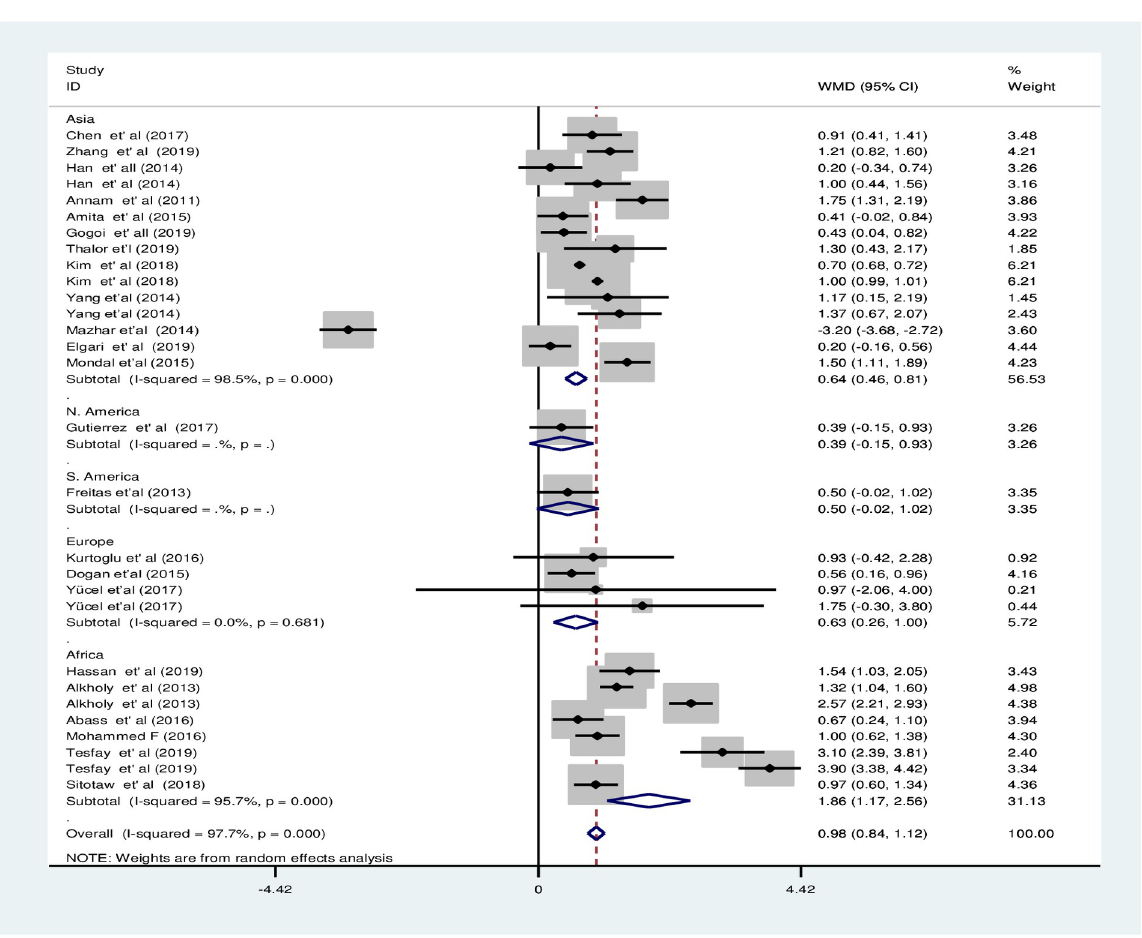
Fig 10. Forest plot of subgroup analysis for the pooled WMD estimate of MPV by continent using random effect model.